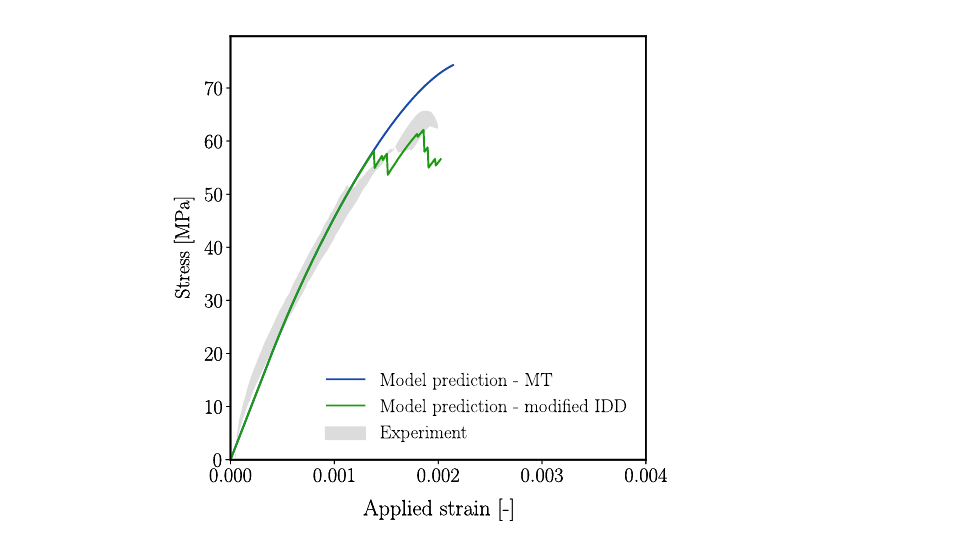
Figure 19. Stress–strain response of concrete numerical sample obtained from Mori–Tanaka scheme (blue), modified IDD scheme (green), in comparison with the experimental range